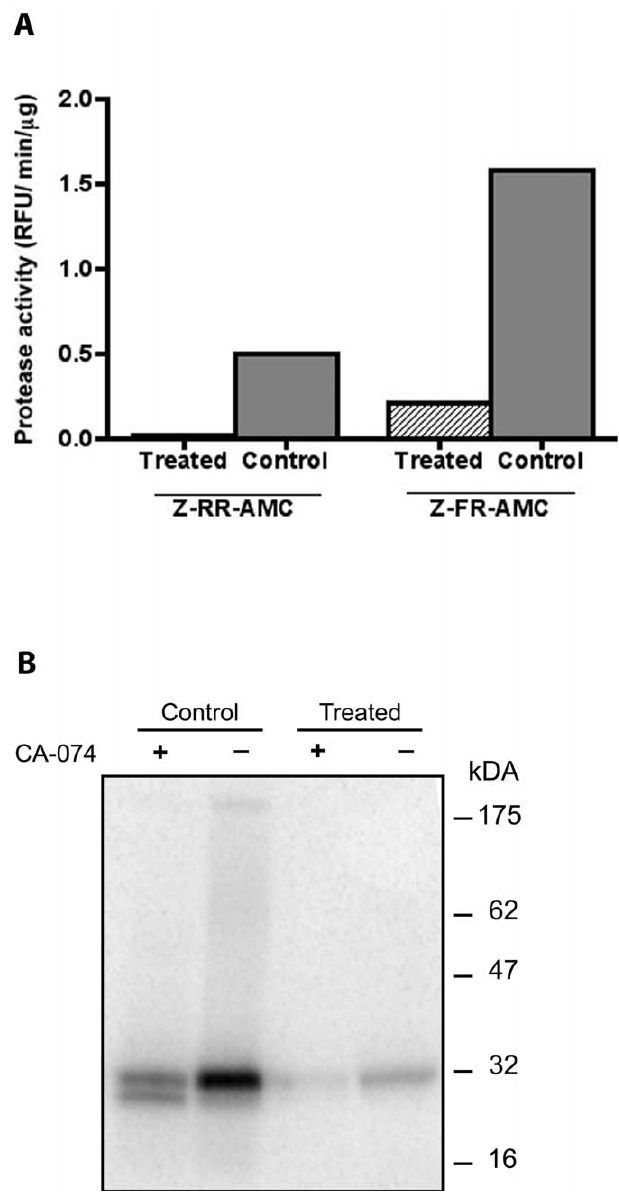
Figure 5. A Principal Molecular Target of K11777 in S. mansoni is the Cathepsin B1 Cysteine Protease (A) Extracts of worms exposed to long-course treatment with K11777 (see Figure 1) had significantly less protease activity (relative fluores- cence units/min/ l g of extract) against the cathepsin B–selective substrate Z-Arg-Arg-AMC (Z-RR-AMC) or the cathepsins B- and